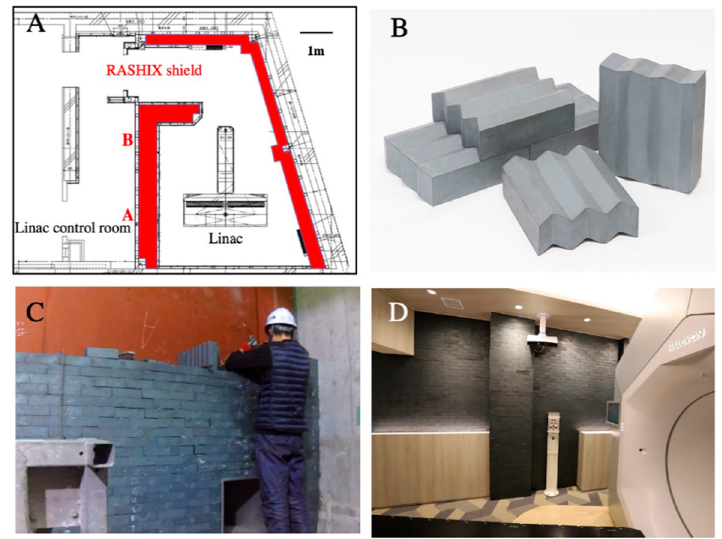
Figure 3. Visual images of Fe 2 O 3 based ceramic bricks used for protection shield in linac room. Shields constructed by the Iron (III) oxide-based ceramic bricks were shown in red.